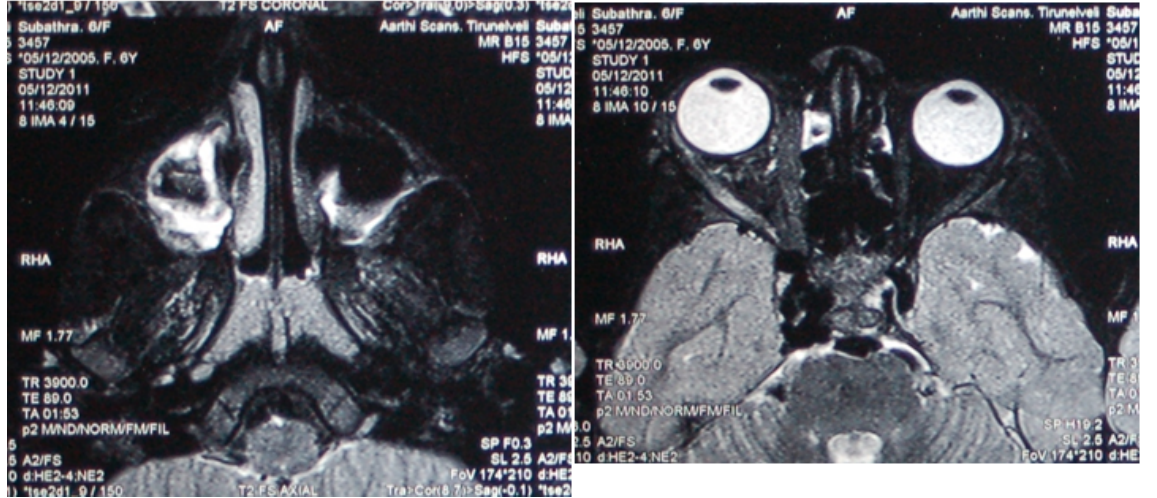
Figure 3: MRI showing exophthalmos in right eye and dilatation of superior ophthalmic vein. managing craniofacial trauma should be most